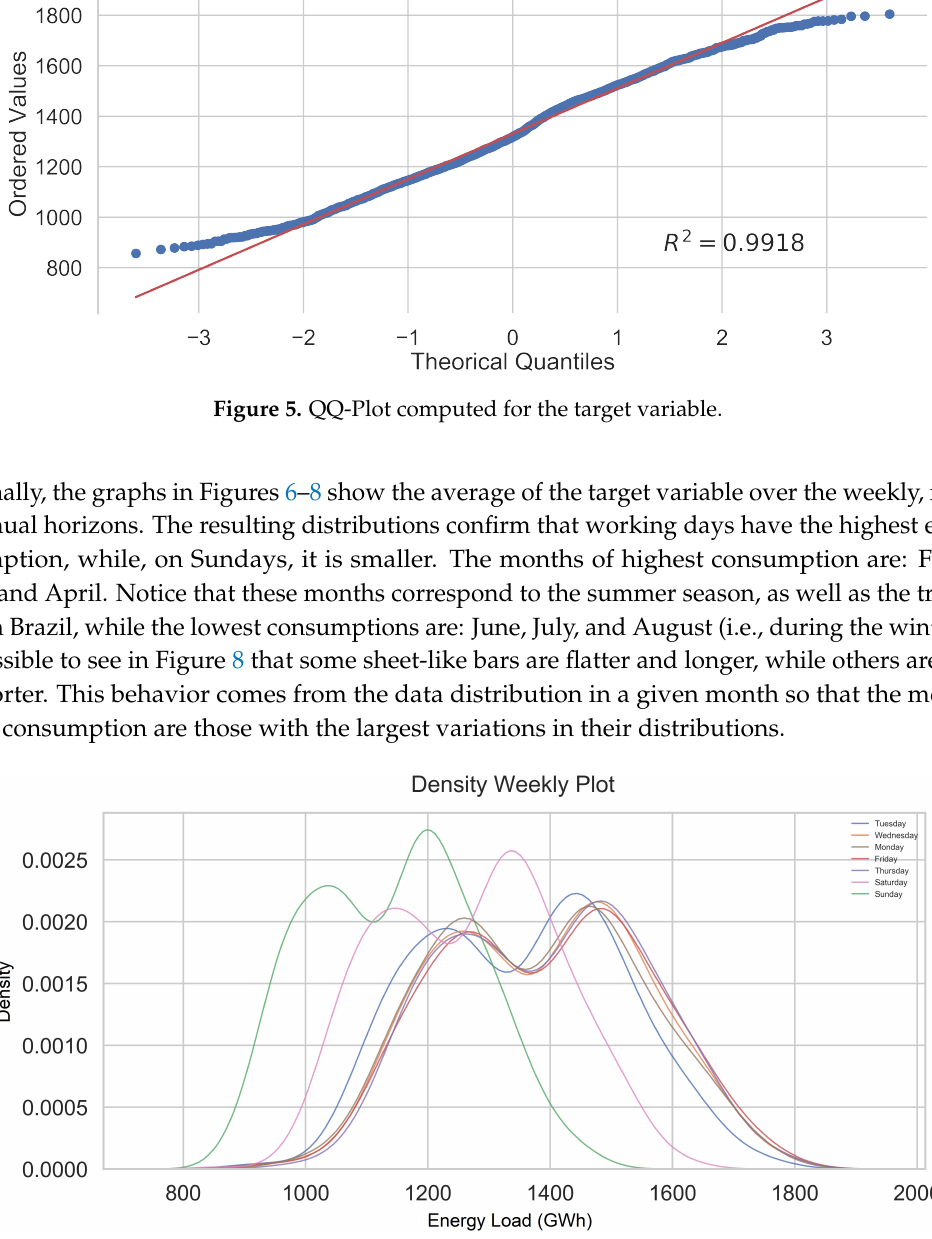
Figure 6. Density plot of weekly average distribution for the Energy Load